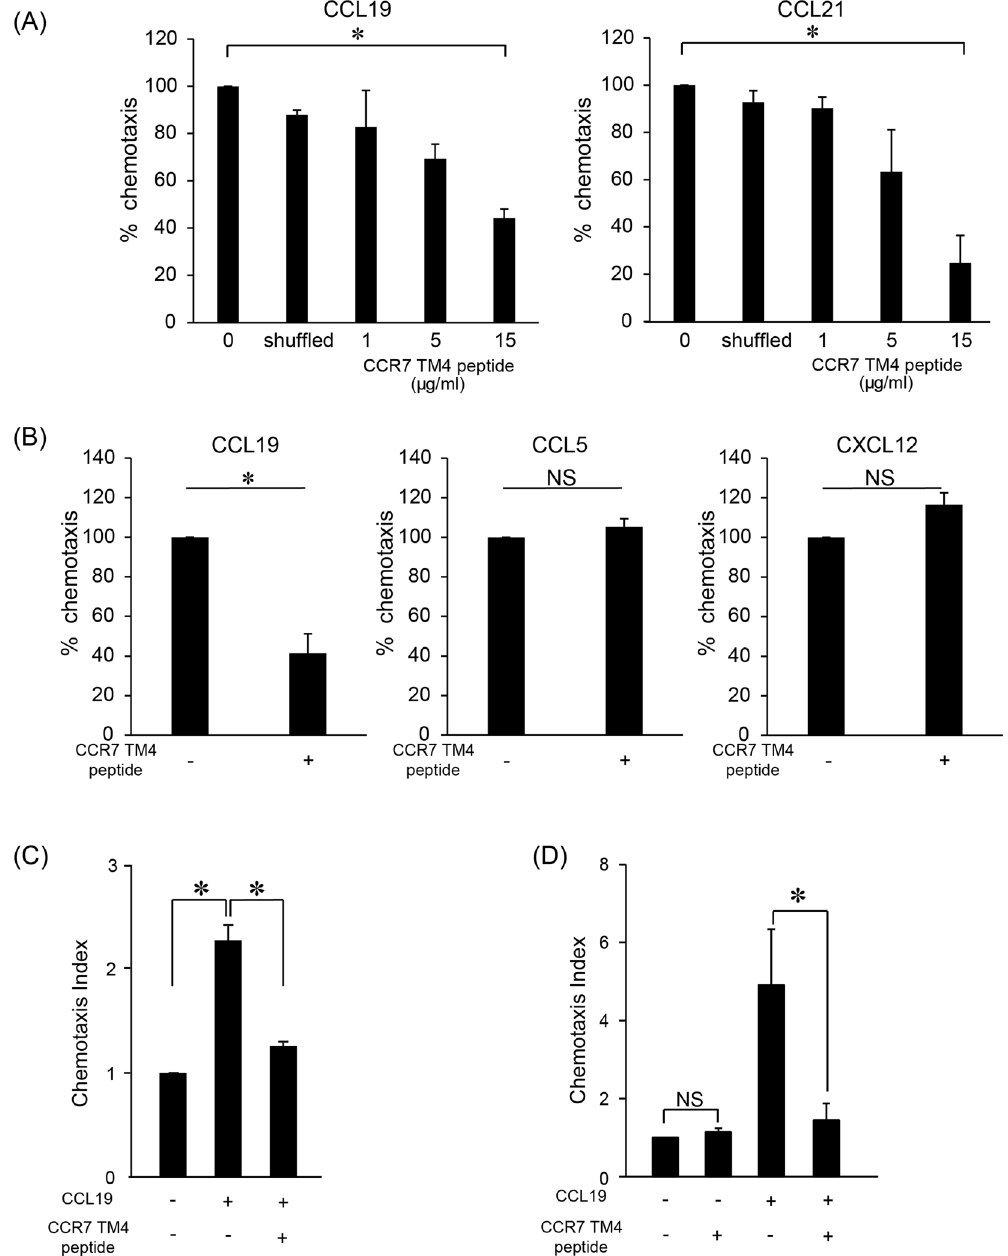
Figure 4. CCR7-dependent cell migration is inhibited by the CCR7 TM4 peptide. ( A ) CCR7-dependent T cell chemotaxis in the presence of the CCR7 TM4 peptide was examined using the Transwell assay. CCL19 (100 ng/ ml, left panel) or CCL21 (100 ng/ml, right panel) was added to the lower wells, and cells premixed with the indicated concentrations of the CCR7 TM4 peptide or 15 μ g/ml of the shuffled peptide were added to the upper wells. The result shown is a representative one from three independent experiments. Data represent mean ± SD of triplicate wells. ( B ) T cell chemotaxis in response to 100 ng/ml CCL19, CXCL12, or CCL5 was examined using the Transwell assay. Each chemokine was added to the lower well, and cells mixed with or without the CCR7 TM4 peptide (15 μ g/ml) were added to the upper well. The percentages of input cells that had migrated to the lower well are shown. The result shown is a representative one from three independent experiments. Data represent mean ± SD of triplicate wells. ( C ) The level of MDA231 cell migration is shown in response to 100 ng/ ml CCL19 with or without the CCR7 TM4 peptide (15 μ g/ml). The number of cells that migrated to the bottom wells of transwell chambers were counted by Hoechst 33342 staining. Data represent mean ± SEM of triplicate experiments. ( D ) Primary human T cell chemotaxis in response to CCL19 in the presence or absence of the CCR7 TM4 peptide (15 μ g/ml). The result shown is a representative one from three independent experiments. Data represent mean ± SD of triplicate wells. * p < 0.05 by Student’s t test; NS, not